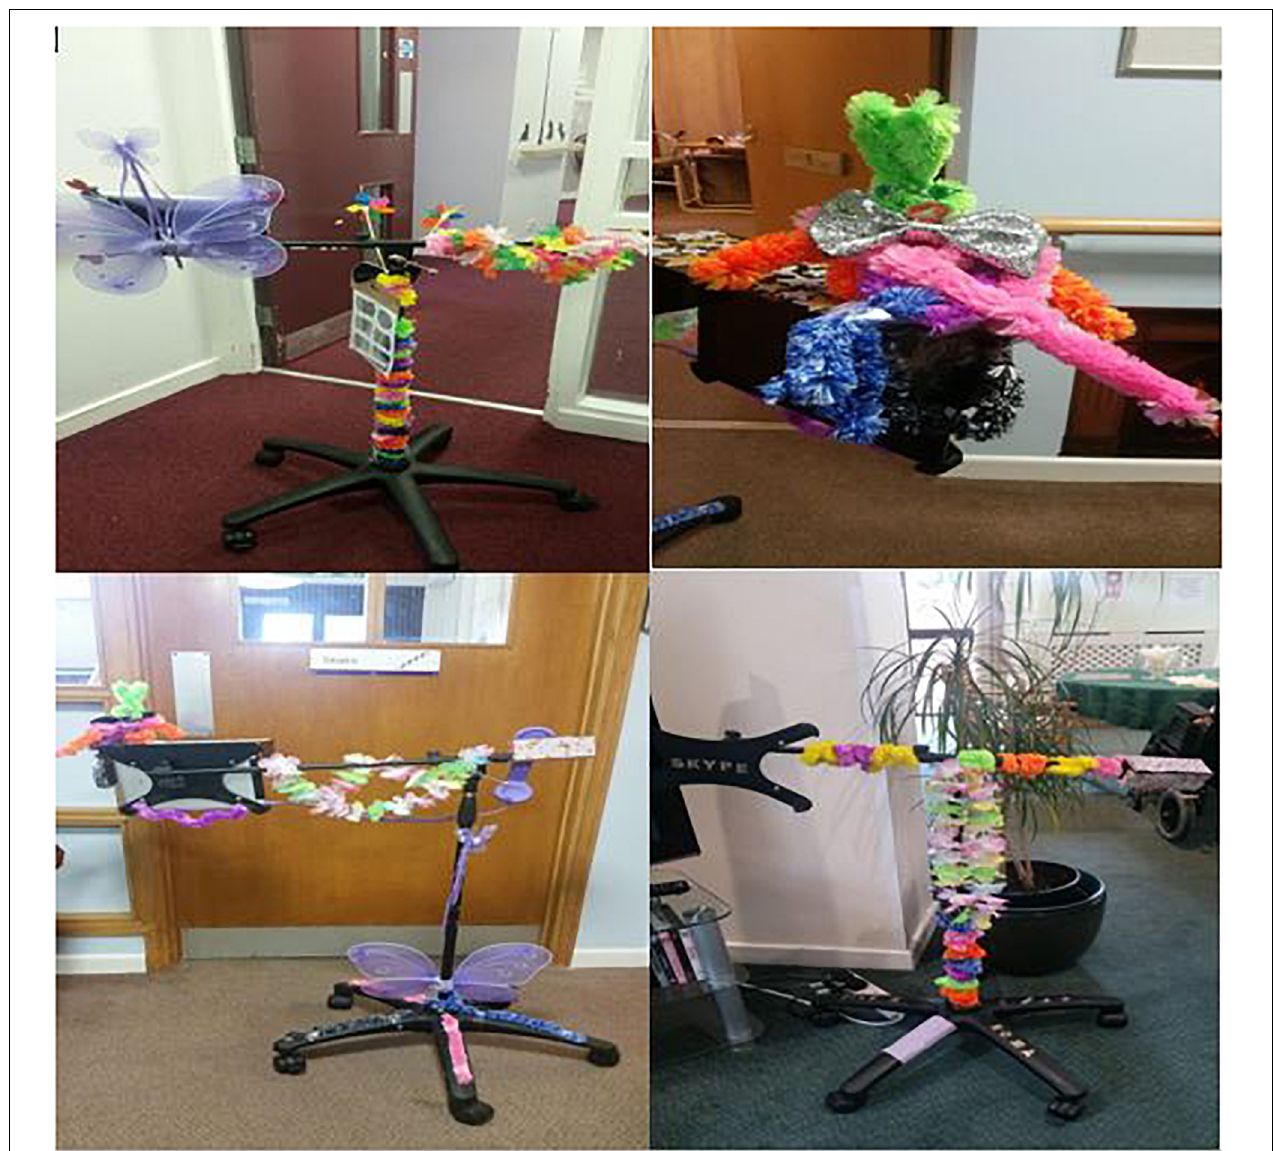
FIGURE 3 | Skype on wheels dressed